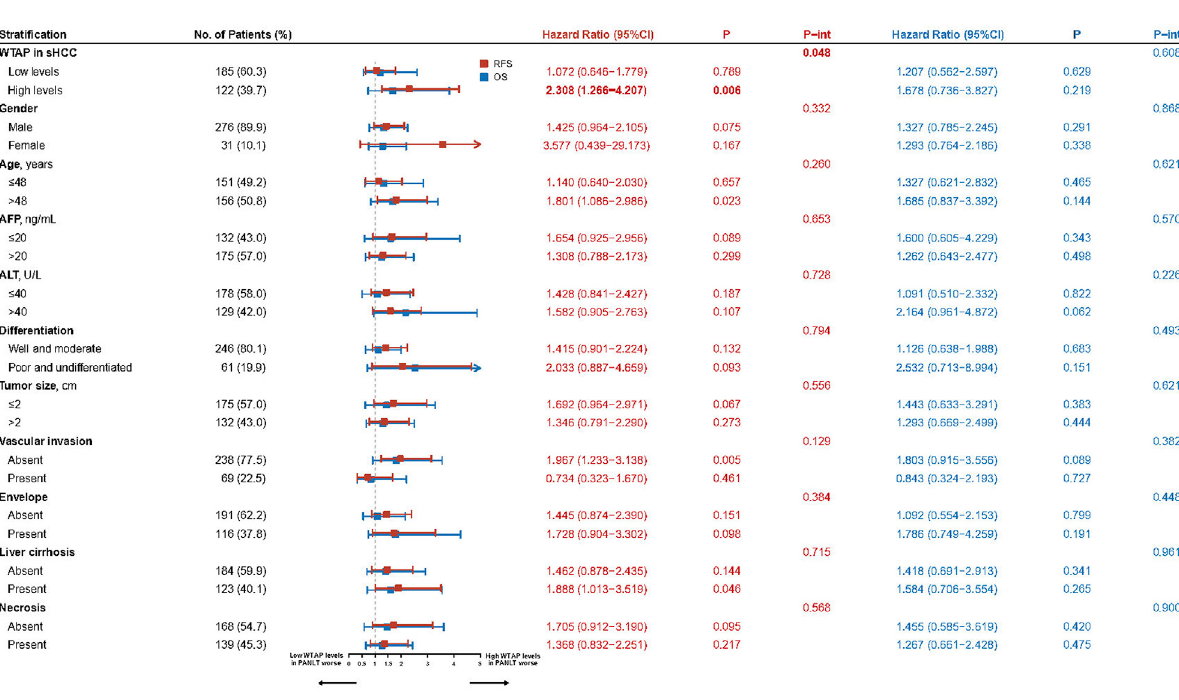
FIGURE 2 Forest plots for the interaction and strati fi cation analyses based on the WTAP levels of PANLT and sHCC for RFS and OS. Abbreviations: CI, con fi dence interval; OS, overall survival; PANLT, the paired adjacent non-neoplastic liver tissues; RFS, recurrence-free survival; sHCC, small hepatocellular